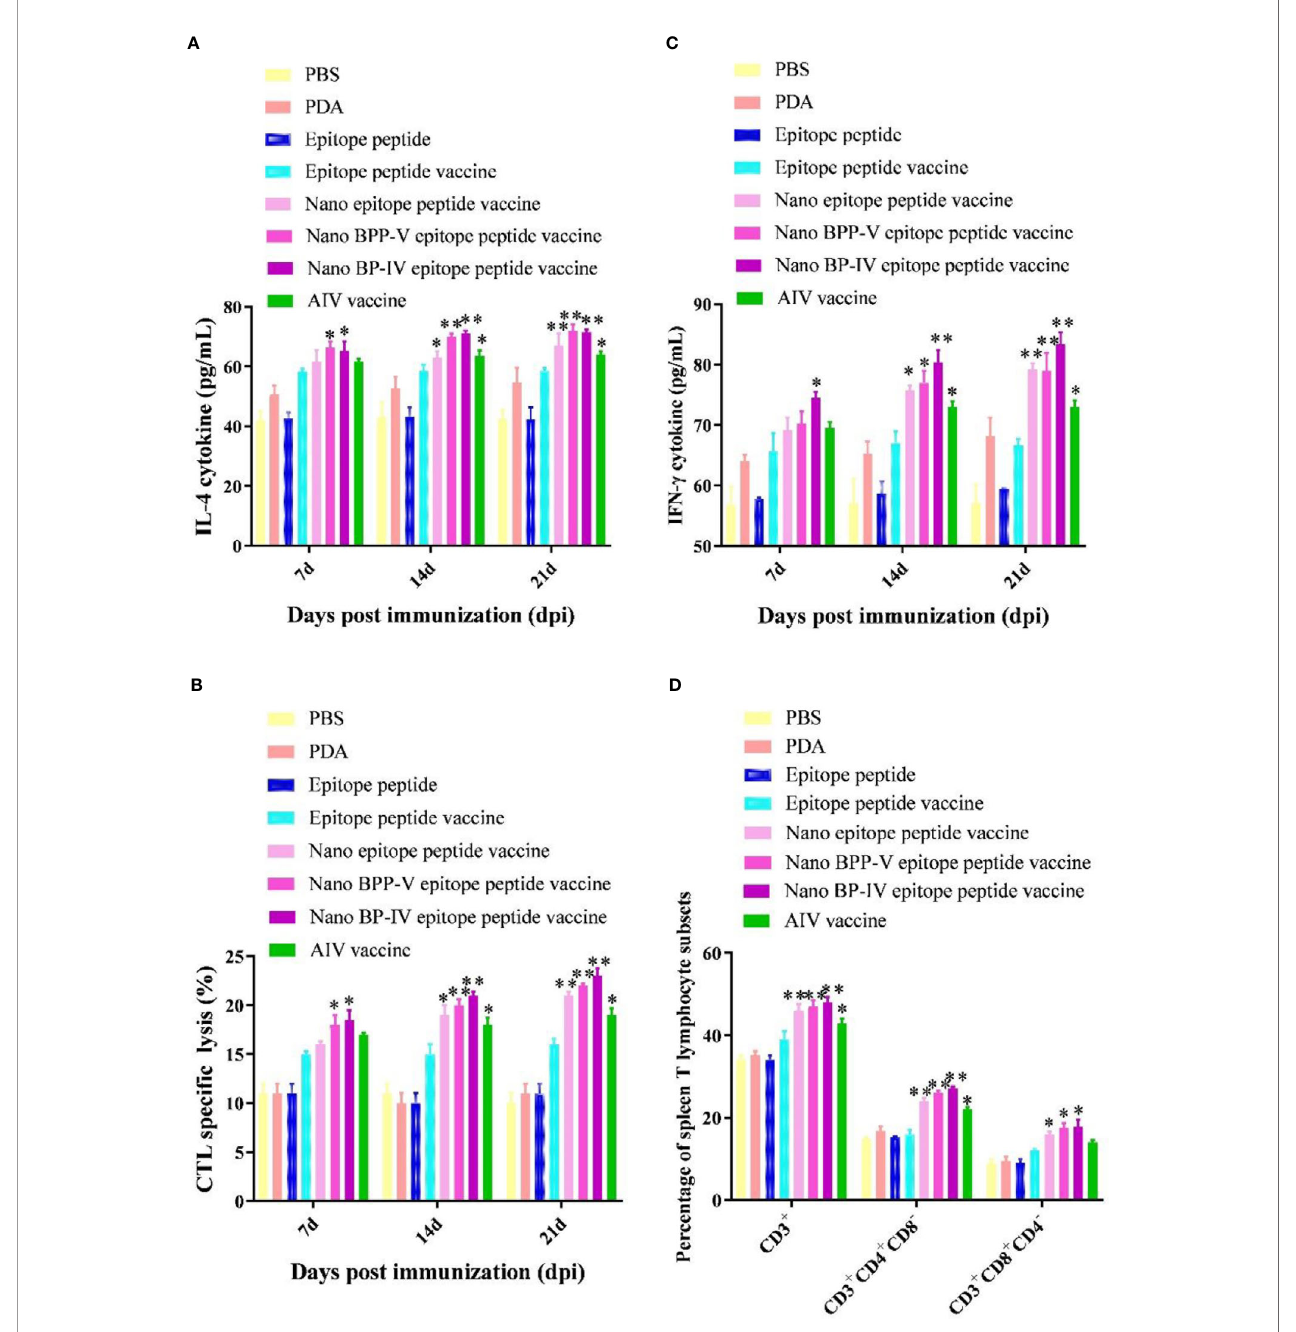
FIGURE 7 | Effects of the nano BPP-V and BP-IV epitope vaccines on the cellular immune responses in immunized mice. The serum levels of IL-4 (A) and IFN- g (B) in immunized mice were detected on days 7, 14, and 21 after immunization. The splenic CTL responses (C) were assessed on days 7, 14, and 21 after immunization, and splenic T lymphocyte typing (D) was performed on day 21 after the immunization. * P < 0.05, ** P < 0.01, compared with the epitope peptide vaccine